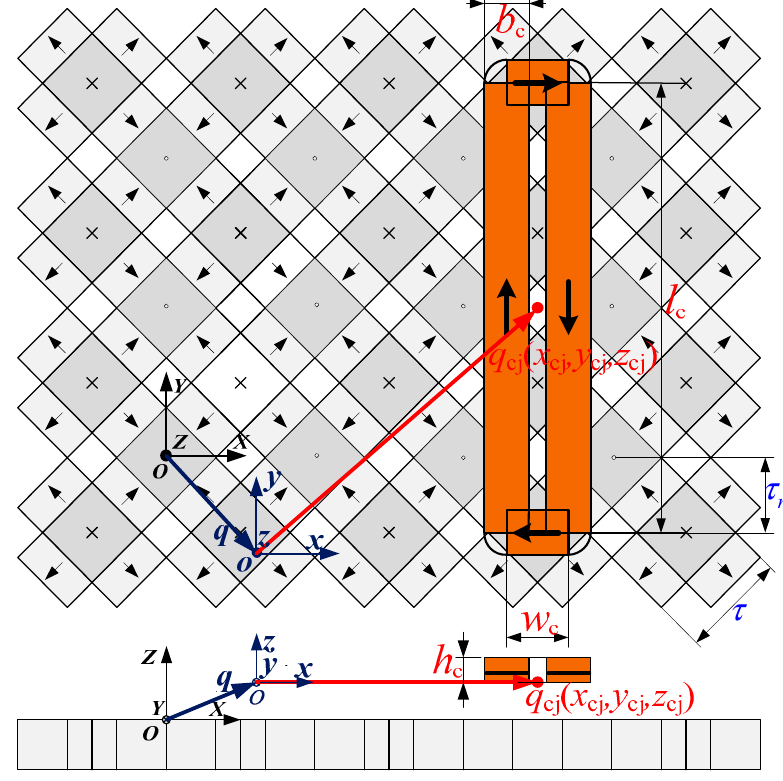
Figure 3. Coordinate systems for modeling of the electromagnetic forces and torques.